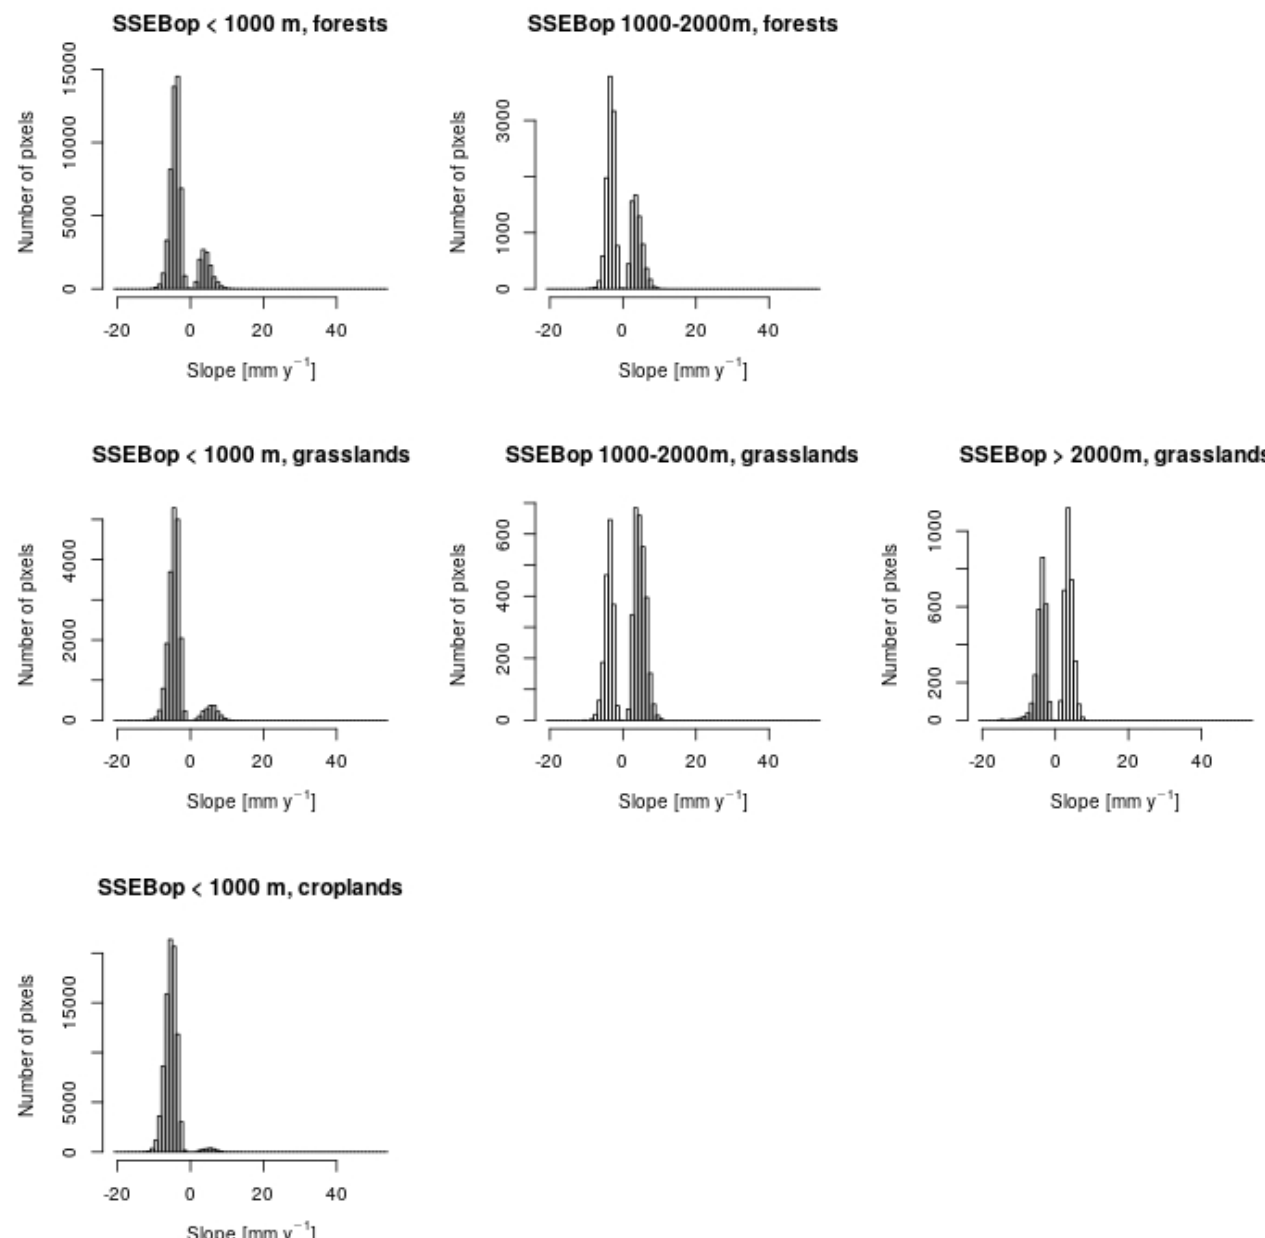
Figure 4. Histograms representing the distribution, within the land cover and elevation classes indicated in the titles, of the Sen’s slope of the trend of SSEBop yearly ET at 5% significance level. On the y axis there are 500 m × 500 m pixels.